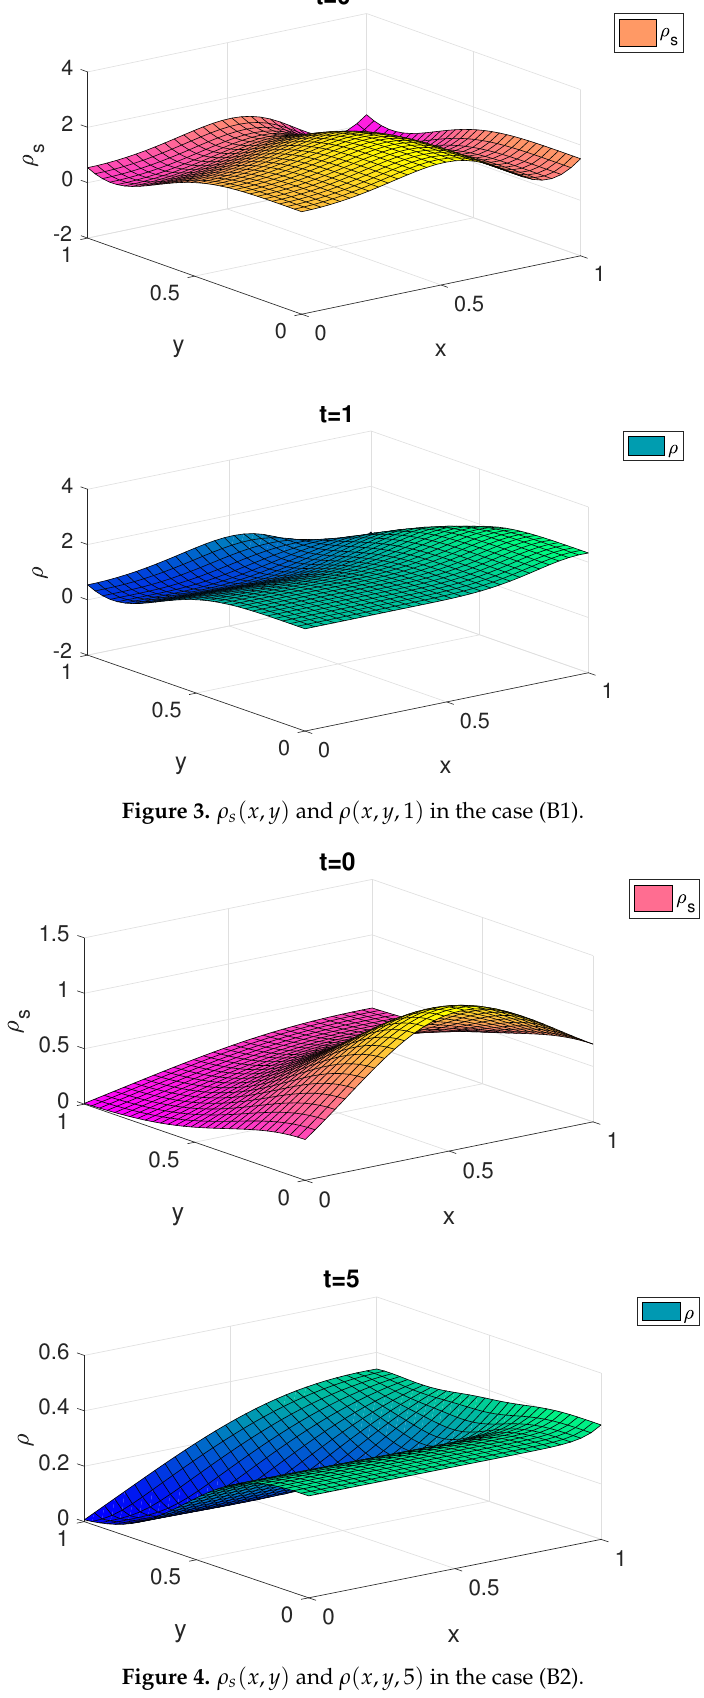
Figure 4. ρ s ( x , y ) and ρ ( x , y ,5 ) in the case